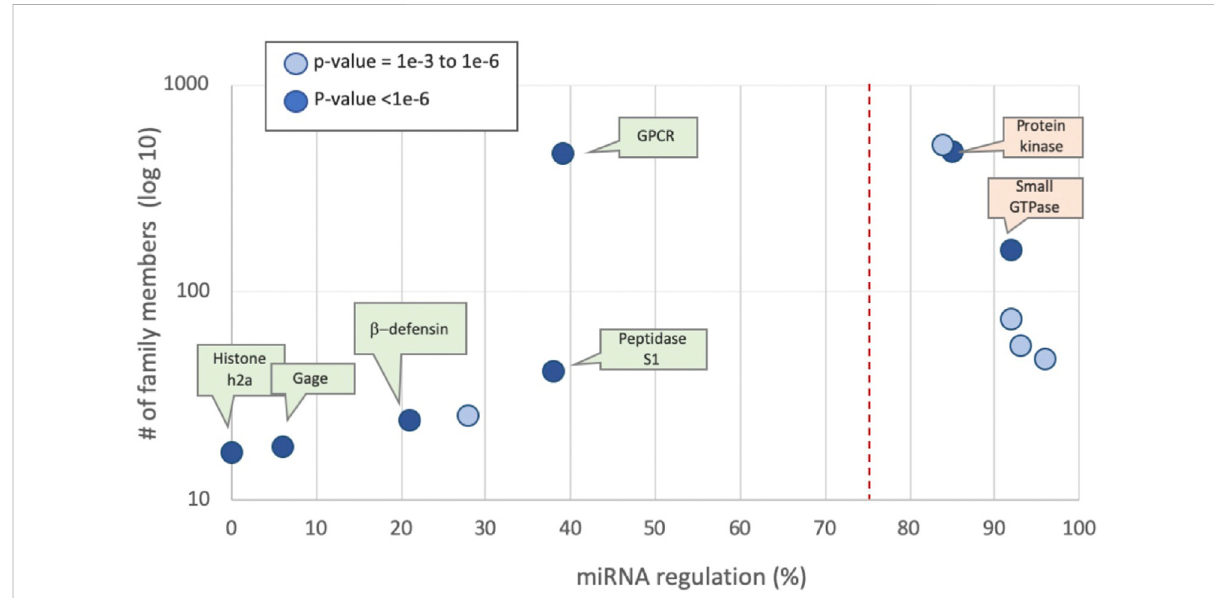
FIGURE 3 Protein families by mean percentage of miRNA regulation predictions of their members. Families de fi ned by UniProtKB. Examples from human families are partitioned by the prior rate for miRNA regulation of 75% (dashed line). The p -value for each family member is marked by the two-sided binomial test. The most signi fi cant families ( p -value < 1E-6 are indicated) are listed, colored green and orange by their predicted values of 0 and 1, respectively. Supplementary Table S4 lists protein families along with their prediction